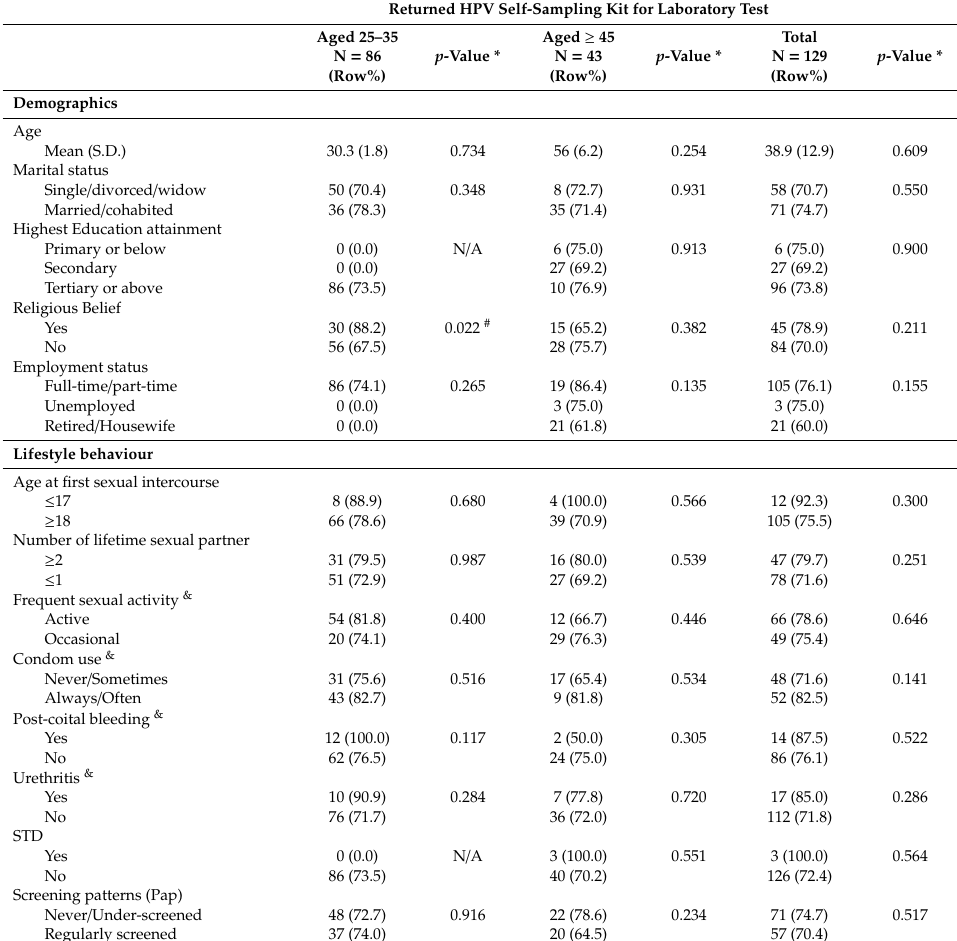
Table 2. Factors associated with uptake of HPV